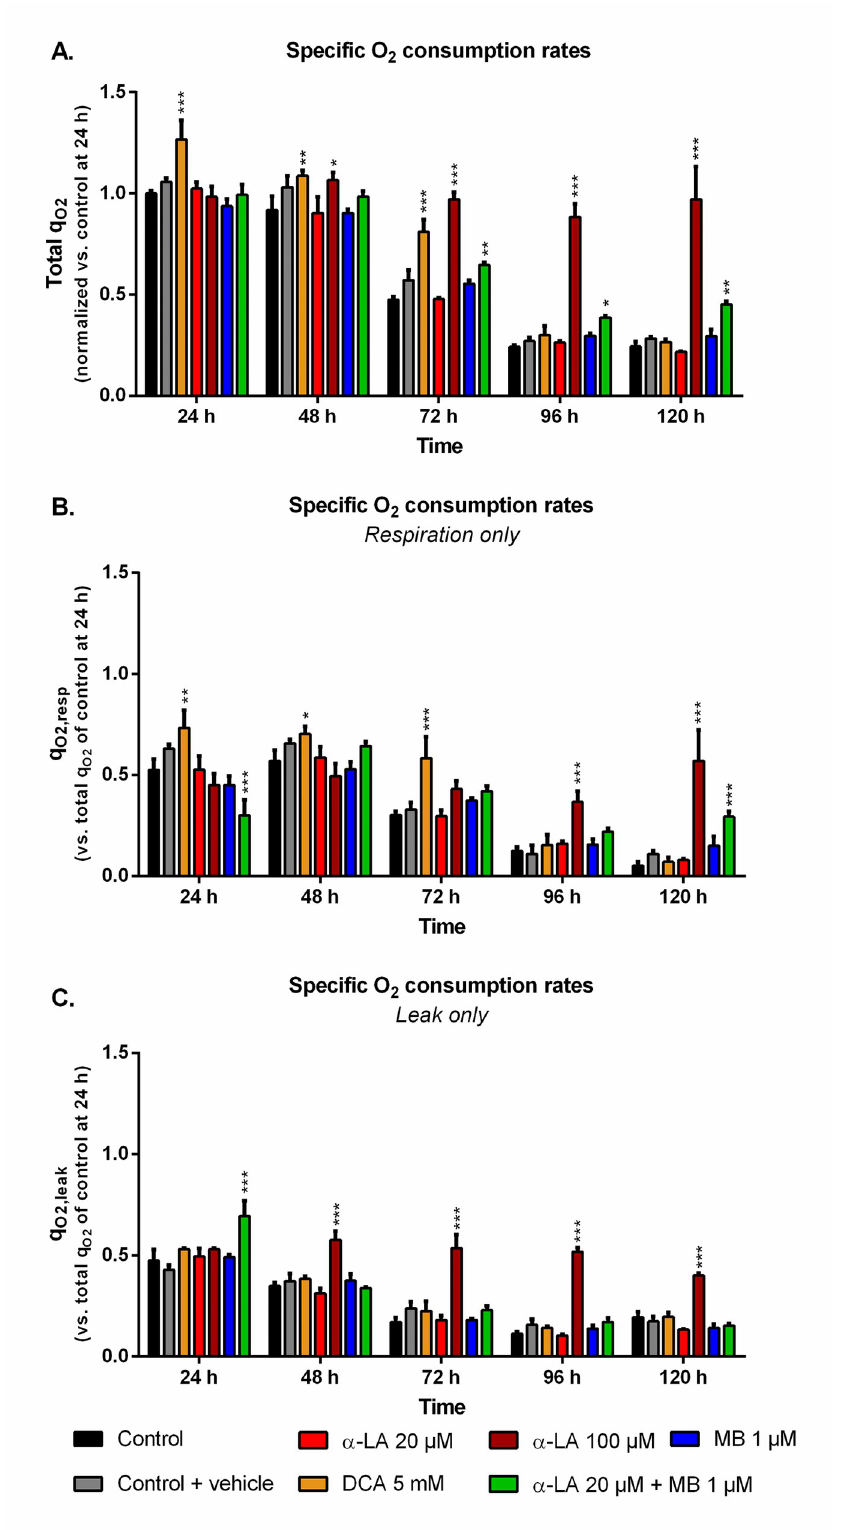
Fig 3. Impact of the various treatments on oxygen consumption.